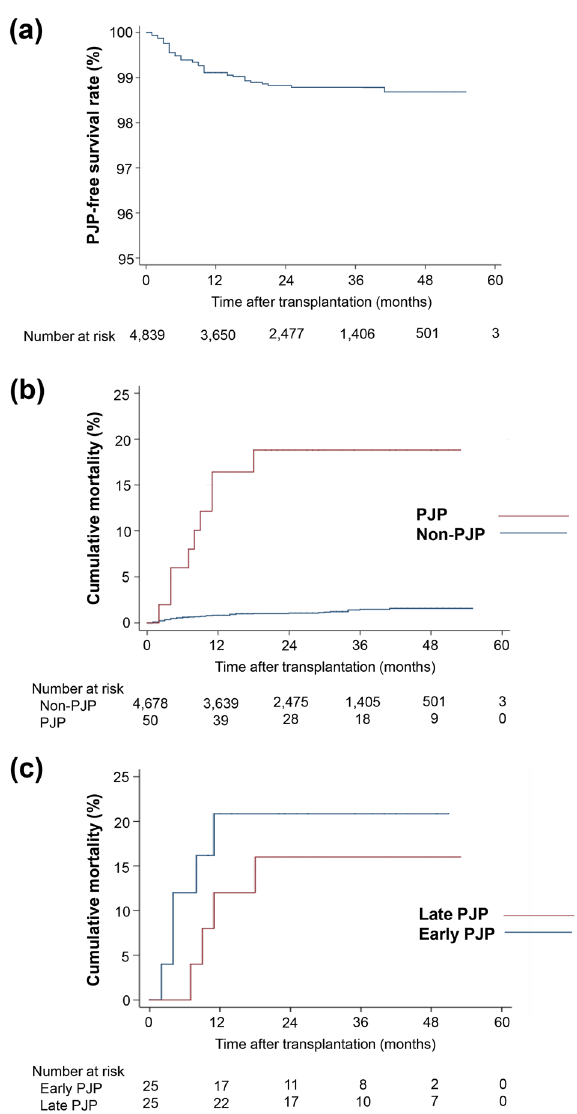
Figure 2. Development of Pneumocystis jirovecii pneumonia and its impact on mortality. ( a ) PJP-free survival rate after kidney transplantation. ( b ) Comparison of mortality between PJP and non-PJP groups (log rank test, P < 0.001). ( c ) Comparison of mortality between early and late PJP groups (log rank test, P = 0.546). PJP, Pneumocystis jirovecii